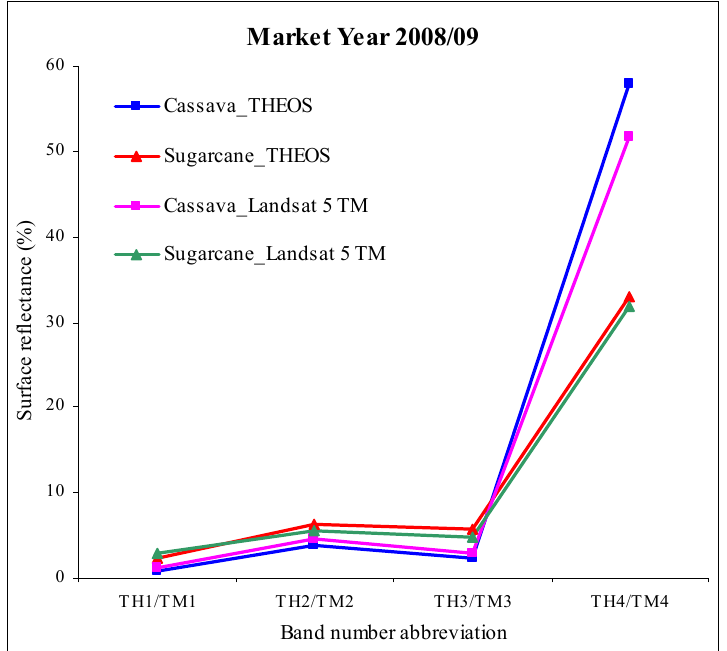
Figure 4. Mean of the percent surface reflectance in the blue, green, red and near-infrared bands of THEOS and Landsat 5 TM for cassava and